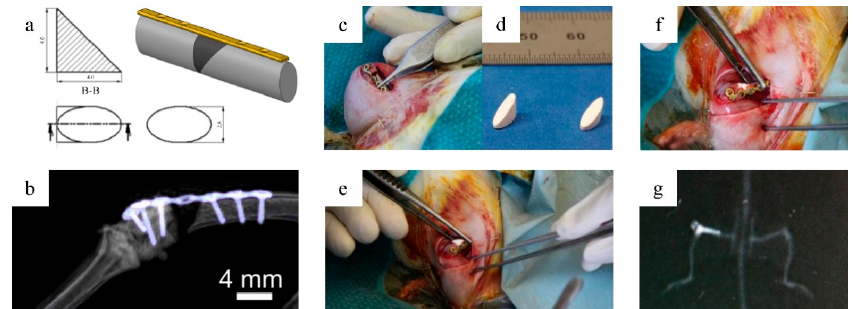
Figure 12. Schematic representation of the wedge-shaped metaphyseal femoral defect in the osteoporotic rat model ( a ); micro-computer tomography of the empty defect according to Alt et al. [16] ( b ); photographs of the blank defect ( c ) and the cut specimen ( d ) as well as defect filling ( e , f ) and post-operative bone density measurement by dual X-ray absorptiometry ( g ).